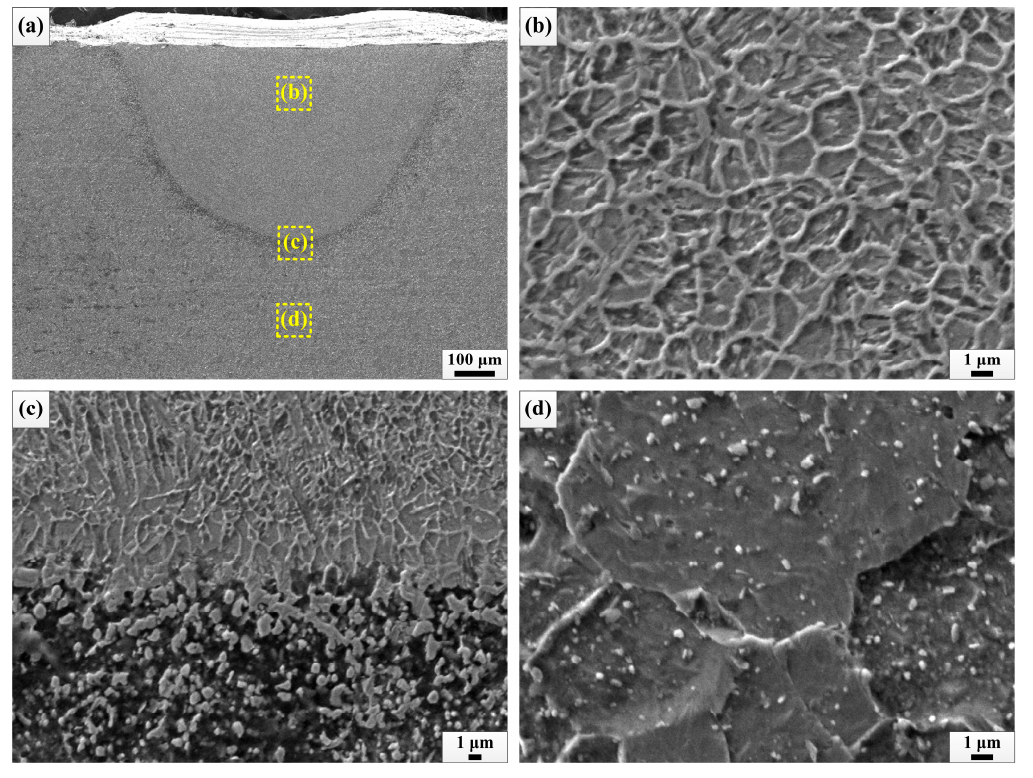
Figure 4. Morphology and microstructure: ( a ) cross-section of LSM-treated specimen, microstructure of ( b ) laser-melted zone, ( c ) interface of laser-melted zone and transition zone, and ( d ) matrix.